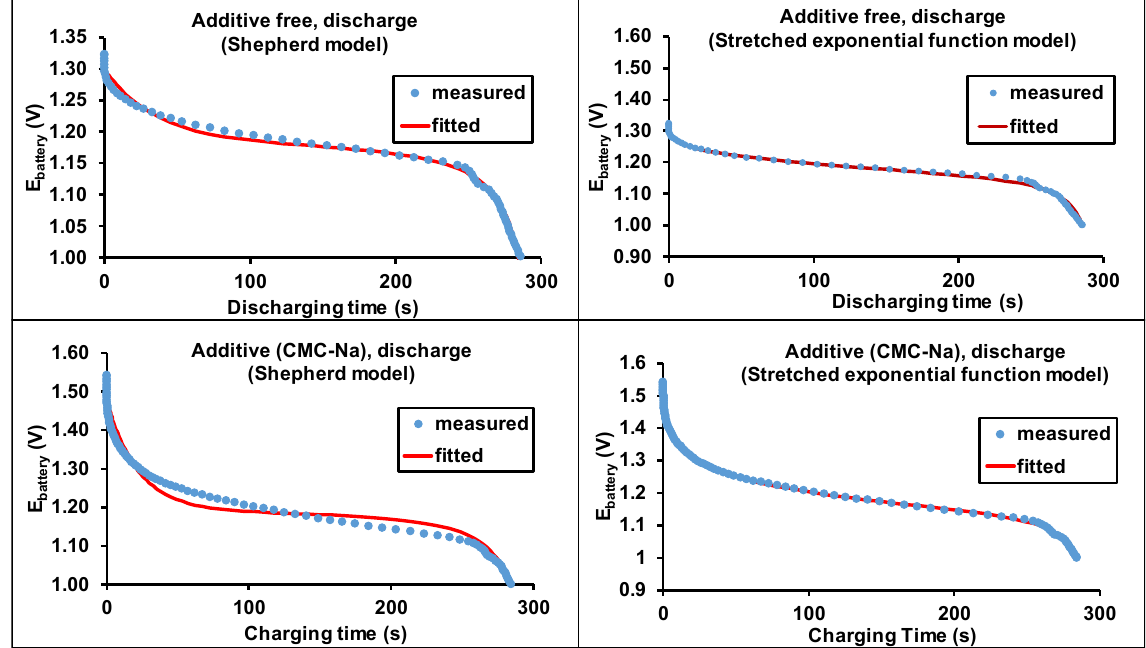
Figure 7. The measured and calculated discharge curves (50th cycle) for the additive-free and CMC-Na salt-containing batteries.